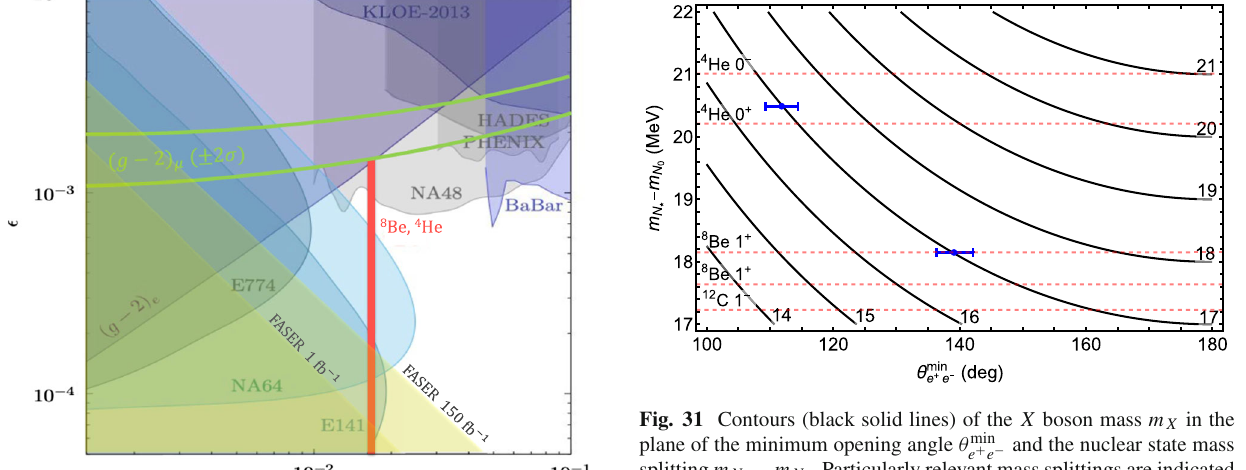
electron coupling, the allowed values are shown in Fig. 30.